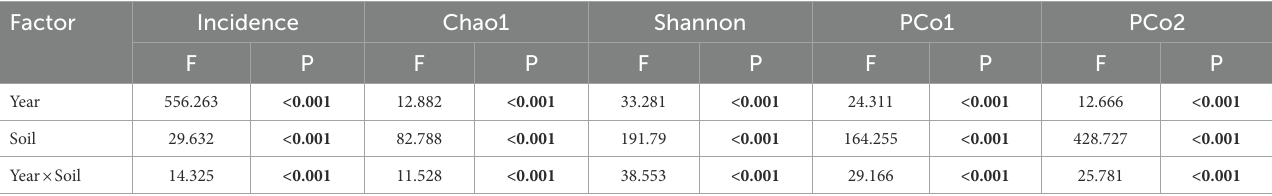
TABLE 1 Two-way ANOVA for Verticillium wilt incidence and soil bacterial community properties as affected by continuous cropping years (year), soil origin (soil) and the interaction (year × soil). Factor Incidence Chao1